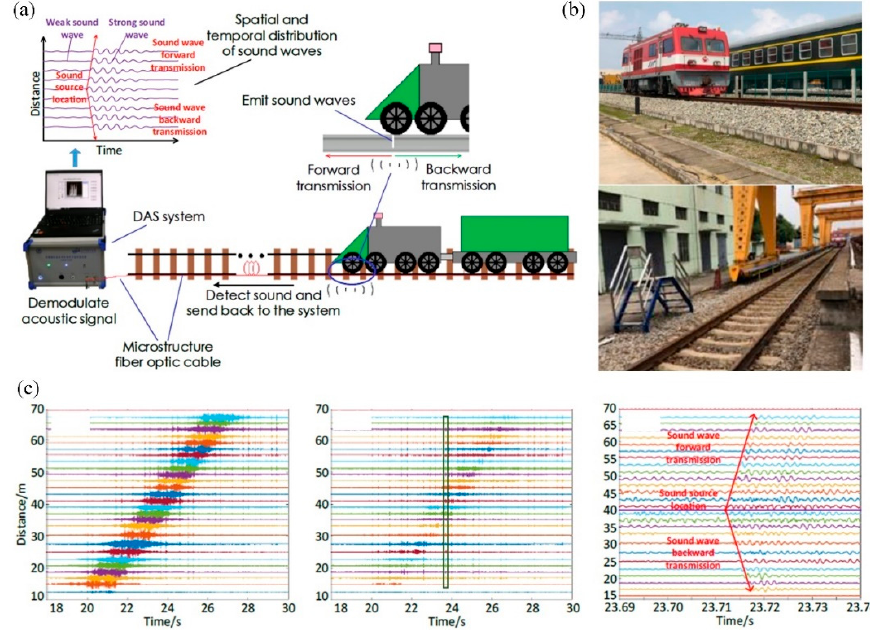
Figure 19. Rail defect detection based on DAS system [80]: ( a ) the process of detecting and analyzing sound waves based on fiber DAS; ( b ) photographs of the field test environment; ( c ) sound distribution measured by